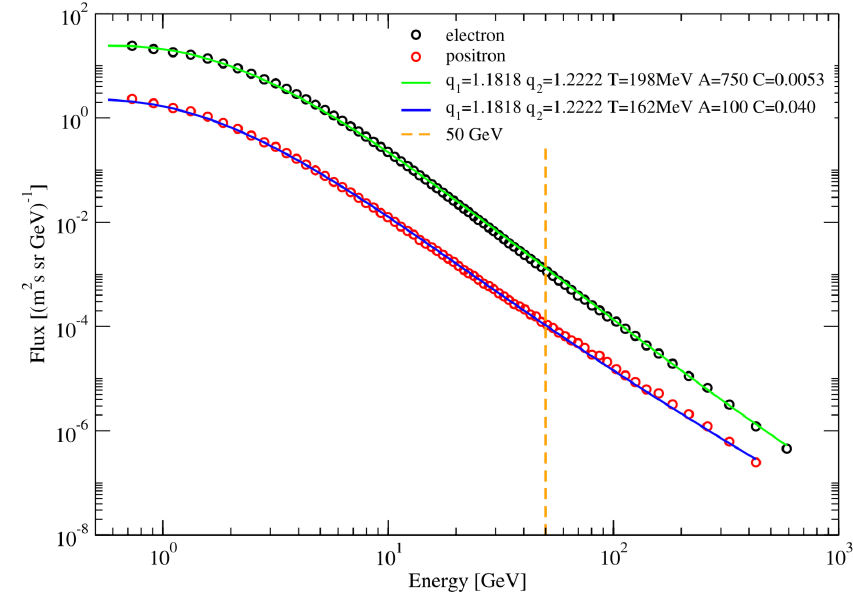
Figure 20. The measured AMS-02 data are very well fitted by linear combination of escort and non-escort distributions (solid lines); q 1 = 13/11 and q 2 = 1/ ( 2 − q 1 ) = 11/9. From